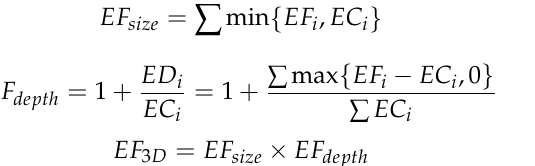
Figure 2. The evolution of ecological footprint model from a one-dimensional model to a three- dimensional model.